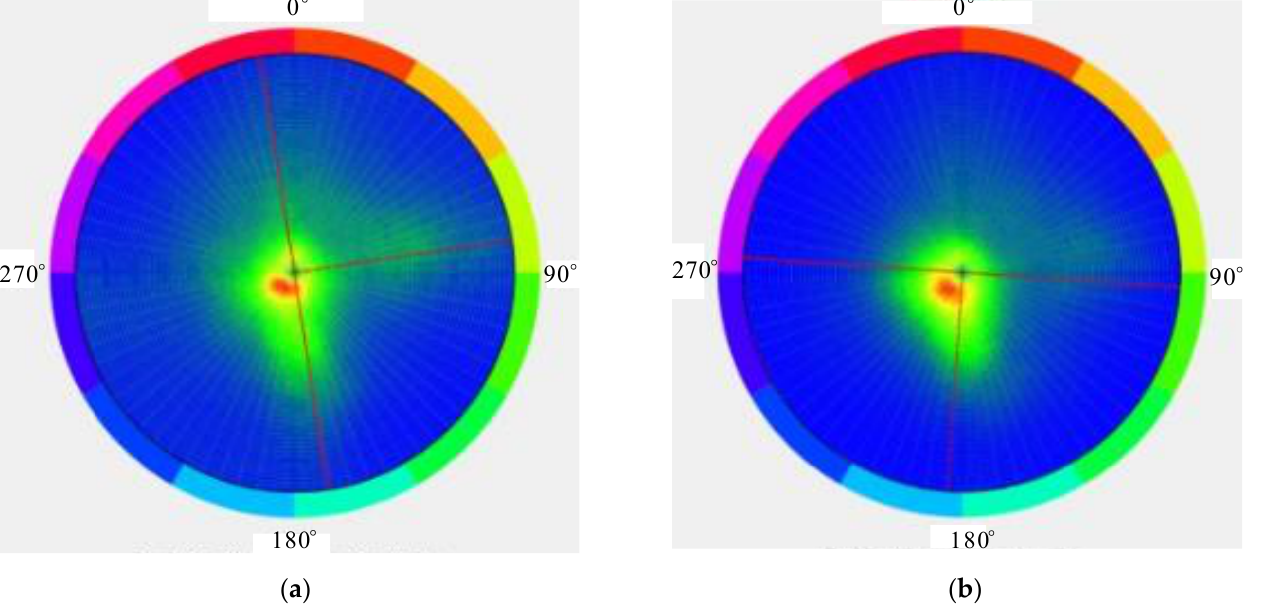
Figure 10. Occurrence distribution of micro-elements of Yangjiaping bank slope. ( a ) Occurrence distribution of micro-elements (17 August 2019). ( b ) Occurrence distribution of micro-elements (12 July 2020).